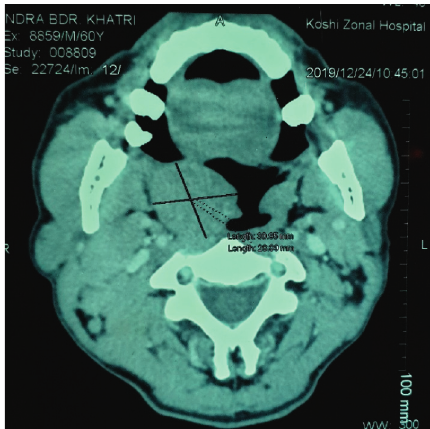
Figure 2: CT scan showing well-defined minimally enhancing isodense soft tissue mass in the